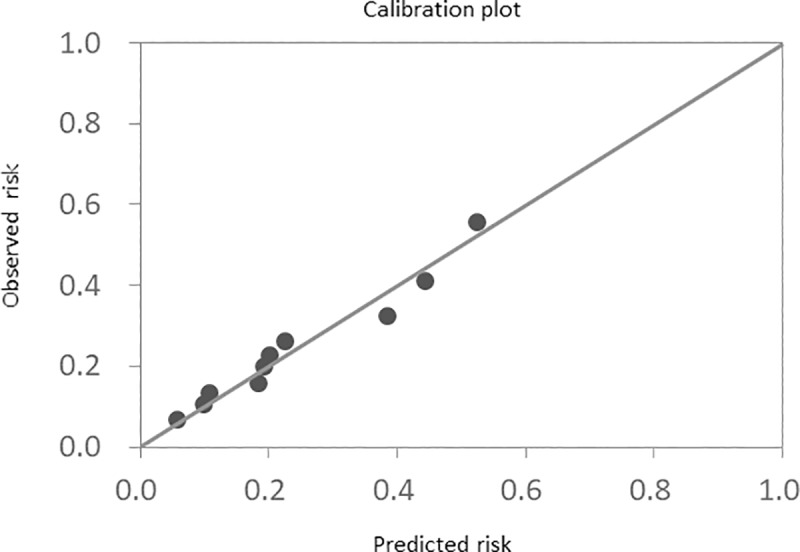
Calibration plot.Calibration plot of the 1-year hospitalization model for worsening of heart failure (external validation).